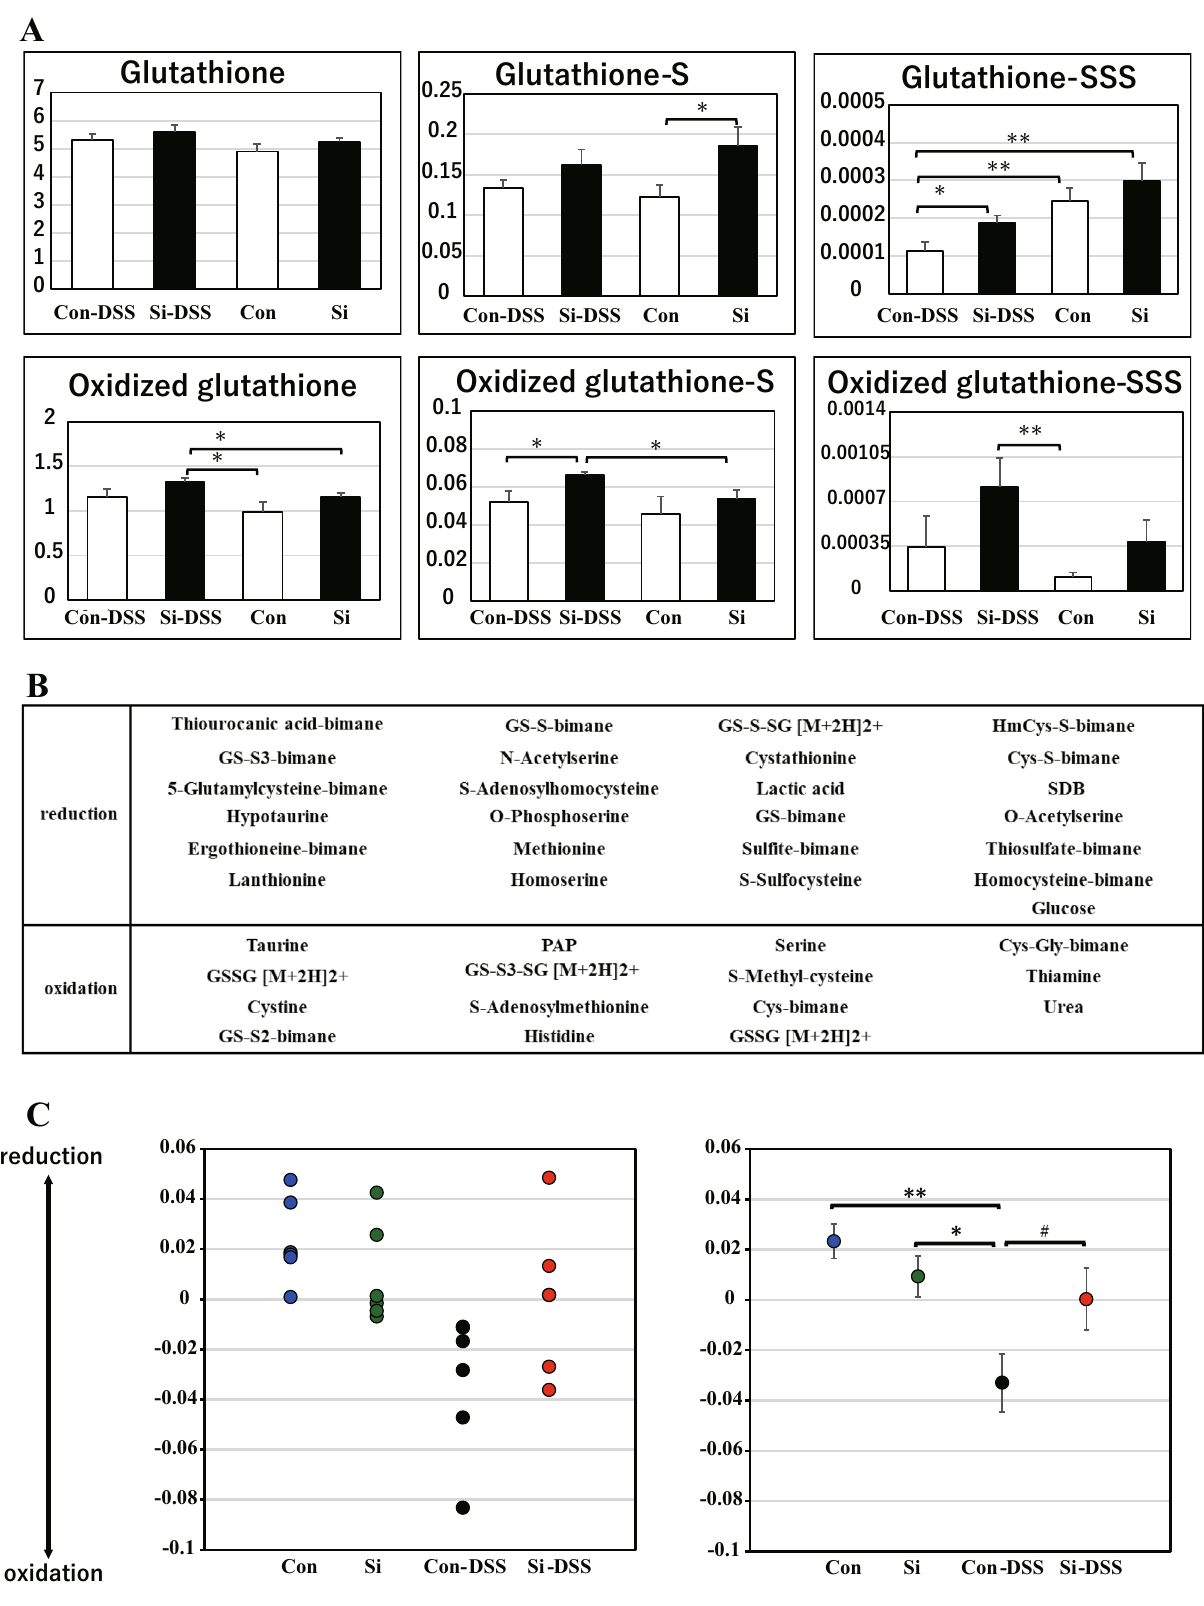
Figure 7. Si-based agent suppressed the intestinal oxidation associated UC via antioxidant sulfur compounds. Sulfur index analysis of the mouse large intestine. The average bar graphs for the expression of glutathione, oxidized glutathione, and each persulfide ( A ). White: control or con-DSS group; black: Si or Si-DSS group. ( B ) Contributory compounds in sulfur-index analysis. ( C ) The dot graph of individual values and the average for sulfur index analysis. Data are expressed as mean ± SEM of six mice per group. ♯ p <